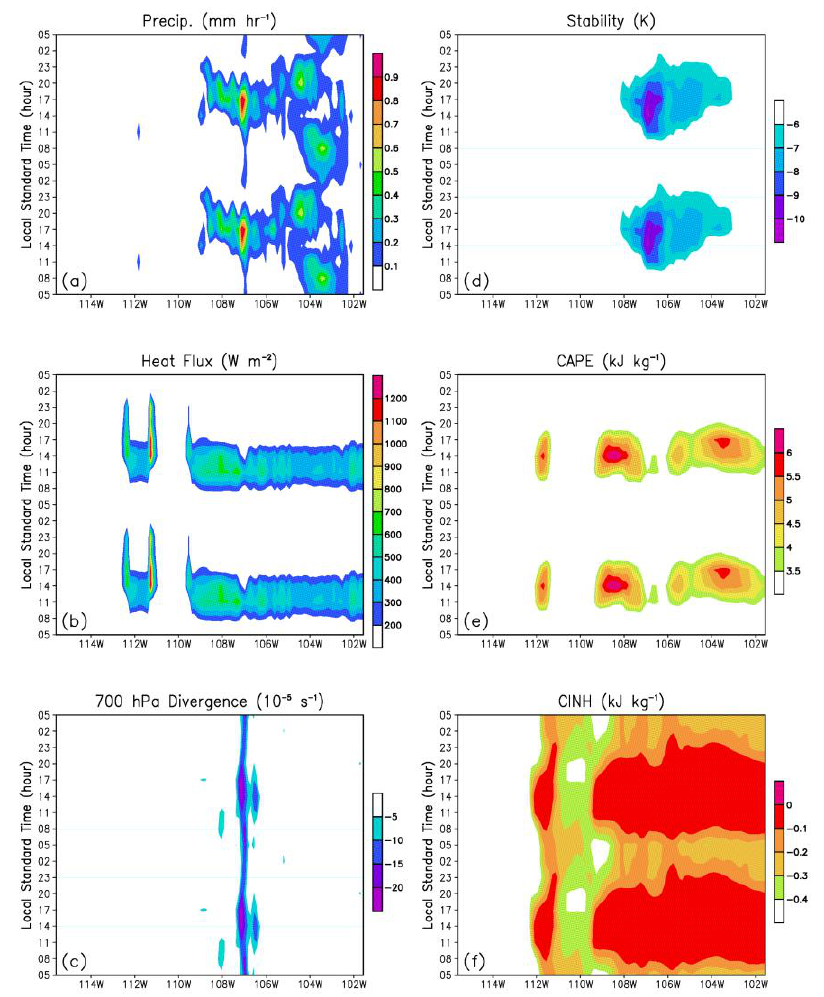
Figure 5. Time-longitude section of (a) precipitation (mm hr −1 ); (b) surface heat